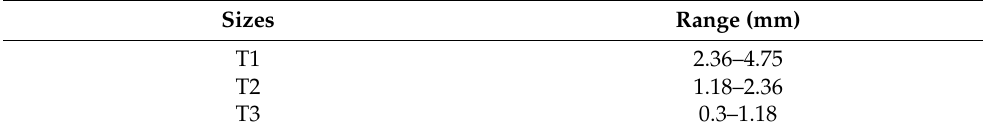
Table 4. Rubber particle